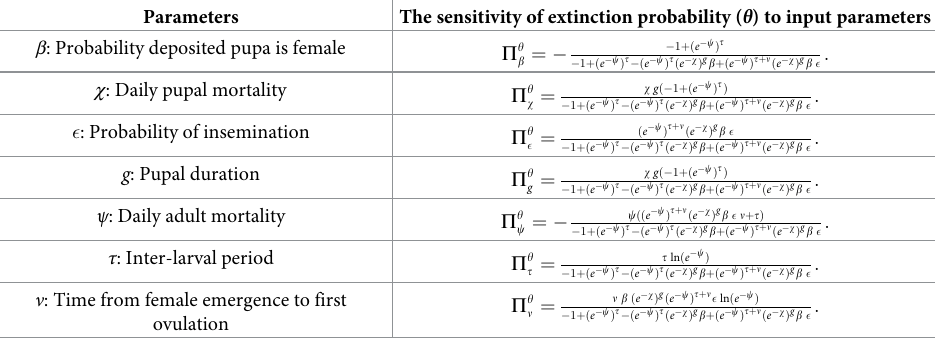
Table 1. Expressions for the sensitivity indices of extinction probability for each parameter. Parameters The sensitivity of extinction probability ( θ ) to input parameters